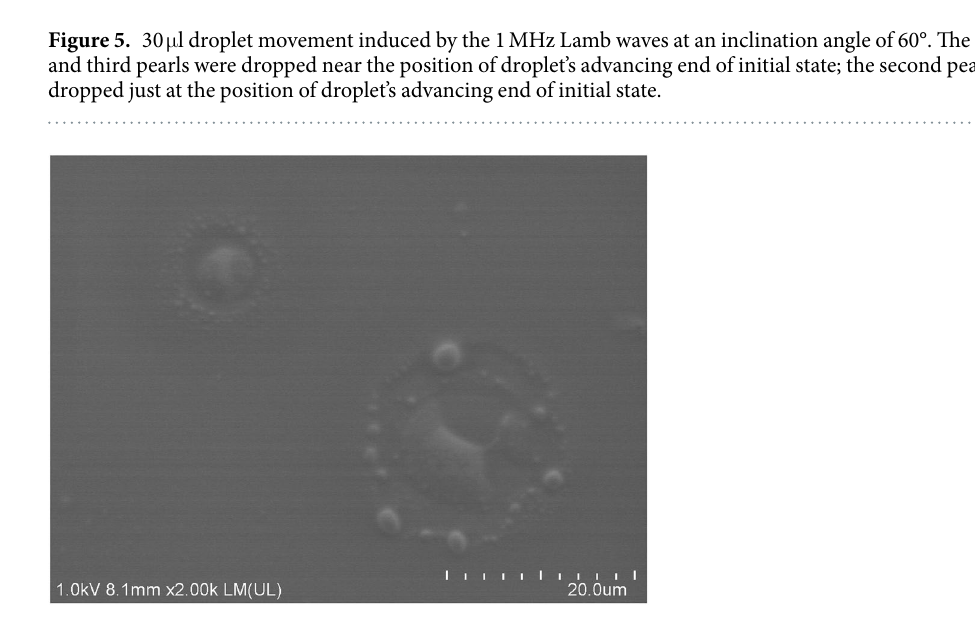
Characterizations. The setup consists of a 20 cm × 20 cm × 1 mm glass plate with an inclination angle of α and a 1mm thick single phase transducer (SPT) attached to the opposite side of substrate (Fig. 1). This transducer